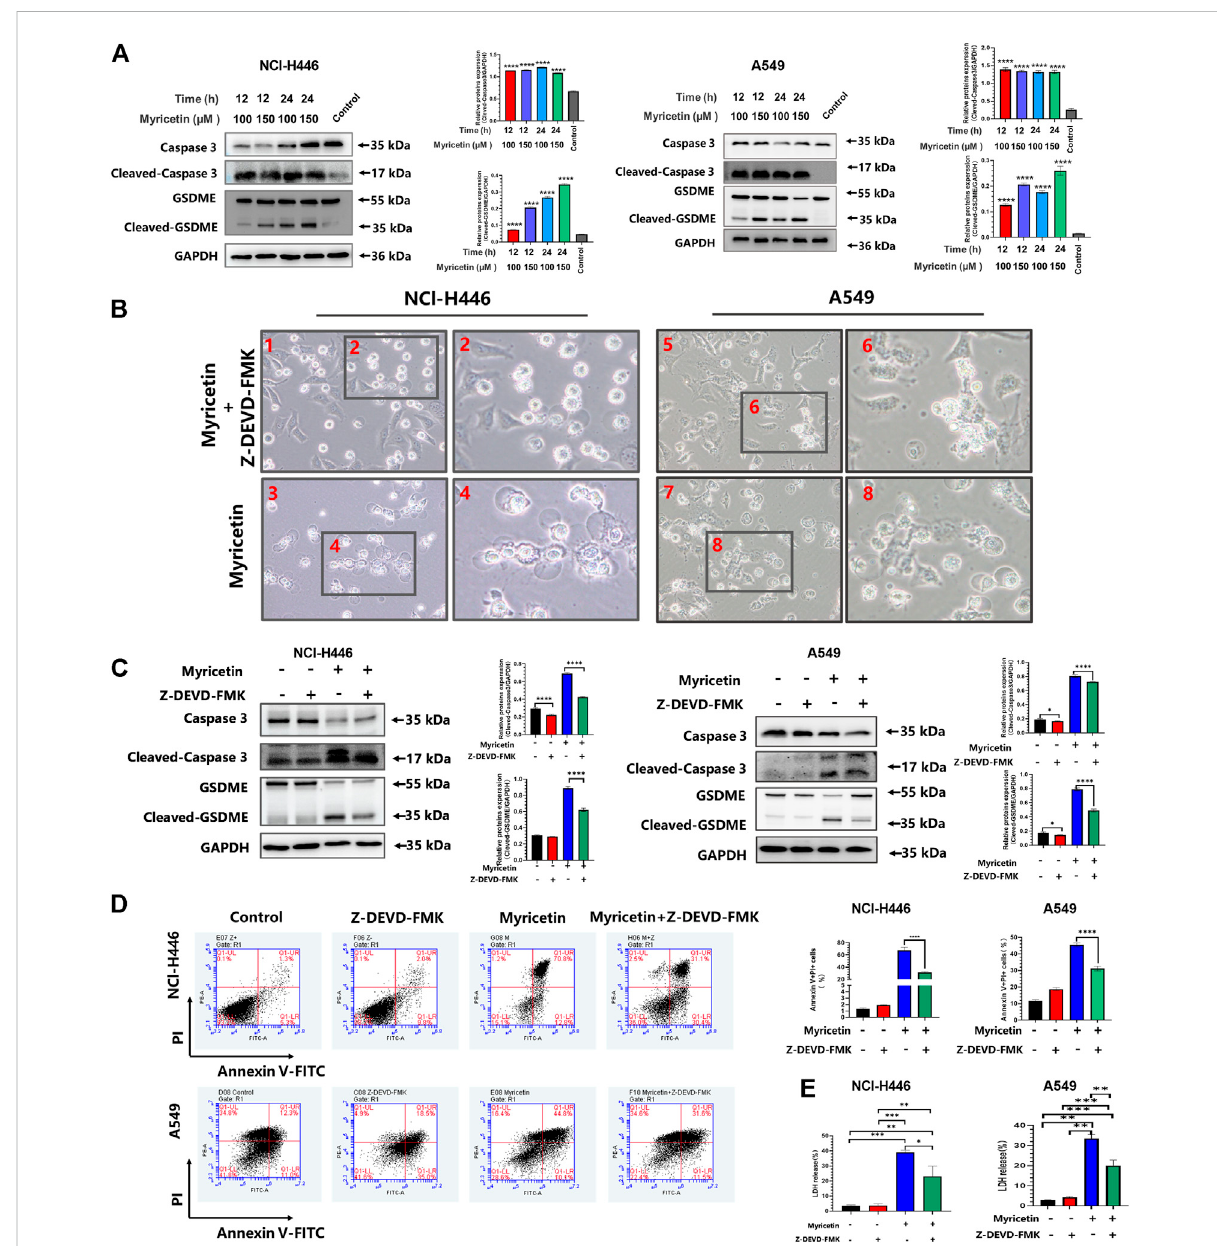
Myricetin-induced pyroptosis depends on Caspase-3. (A) Expression of cleaved caspase-3 and GSDME after myricetin treatment for 12 and 24 h and its statistical analysis. (B) Microscopic imaging of NCI-H446 and A549 cells treated with myricetinand acaspase-3 inhibitor